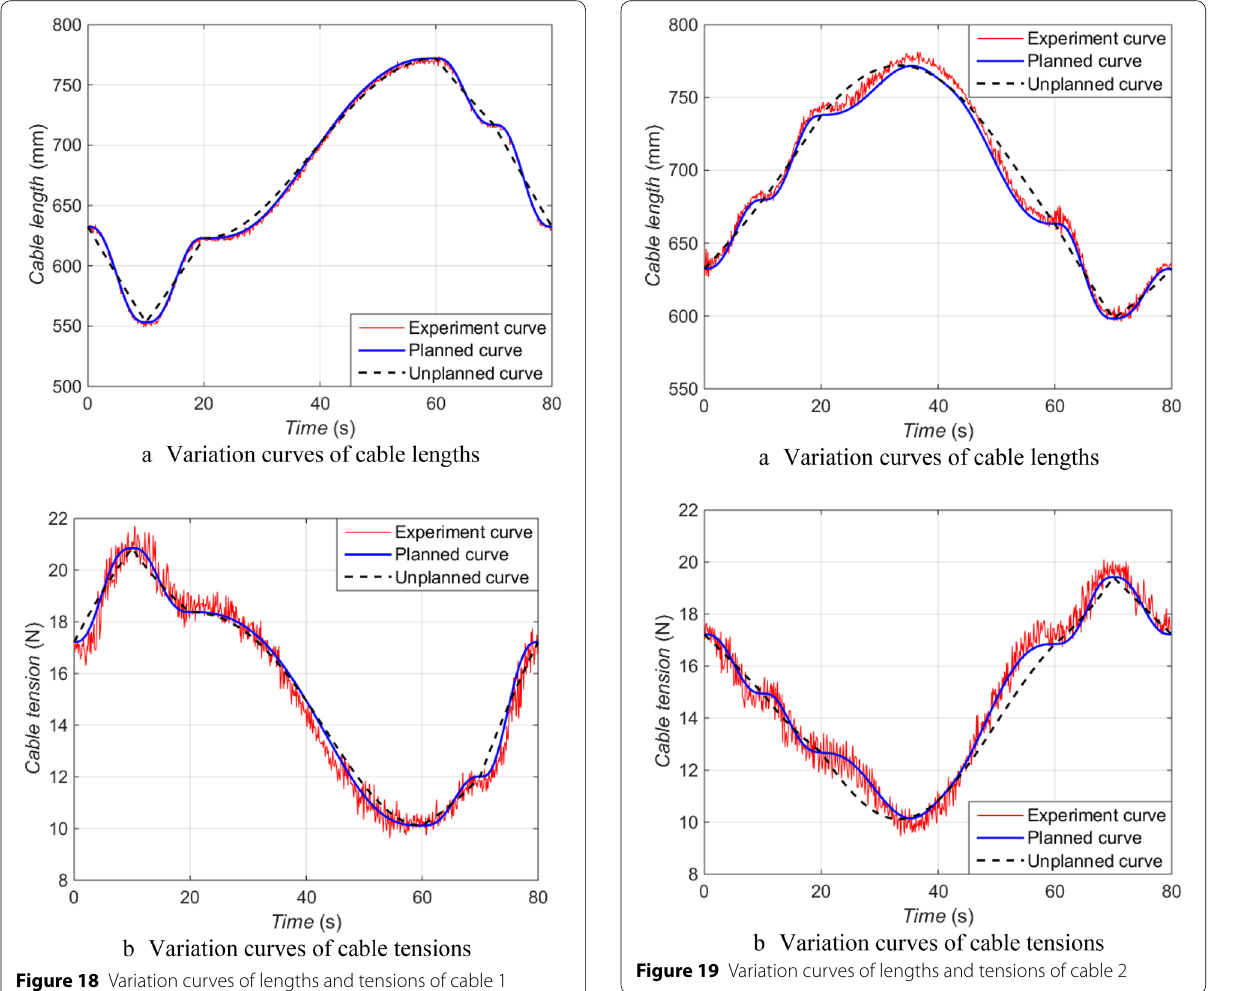
mial planning, and the black dotted line stands for the unplanned curve.